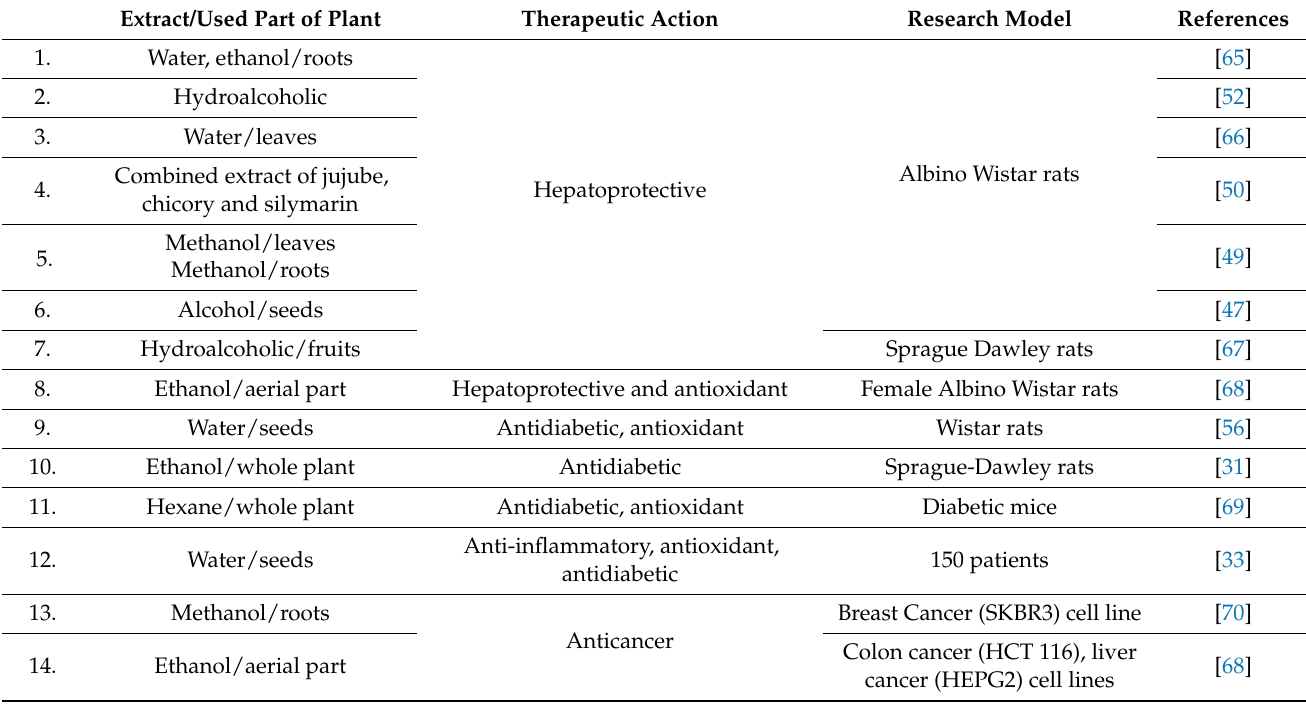
Table 3. Chicory extracts and their activity in different